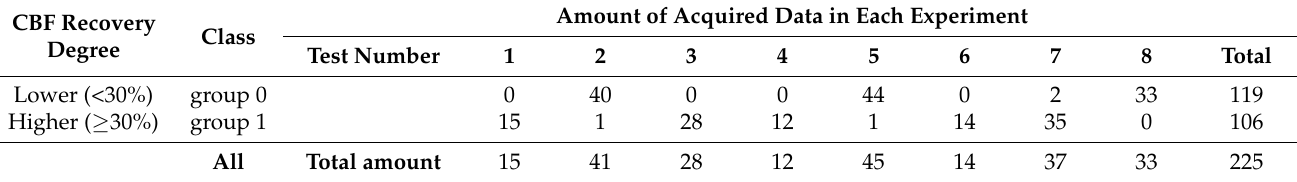
Table 2. Number of EEG epochs with CBF recovery